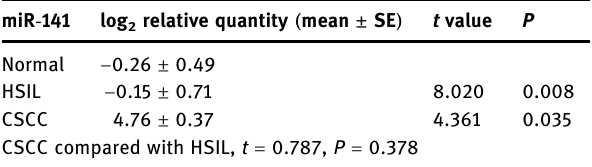
Table 4: Relationship between miR - 141/miR - 340 and clinicopatho - logical features of